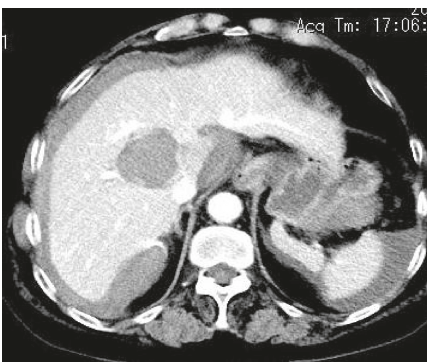
Figure 1: Abdominal CT revealed rupture of the posterior lobe lesion, hemorrhage around the liver, and accumulation of fluid in the abdominal cavity and pelvic cavity.